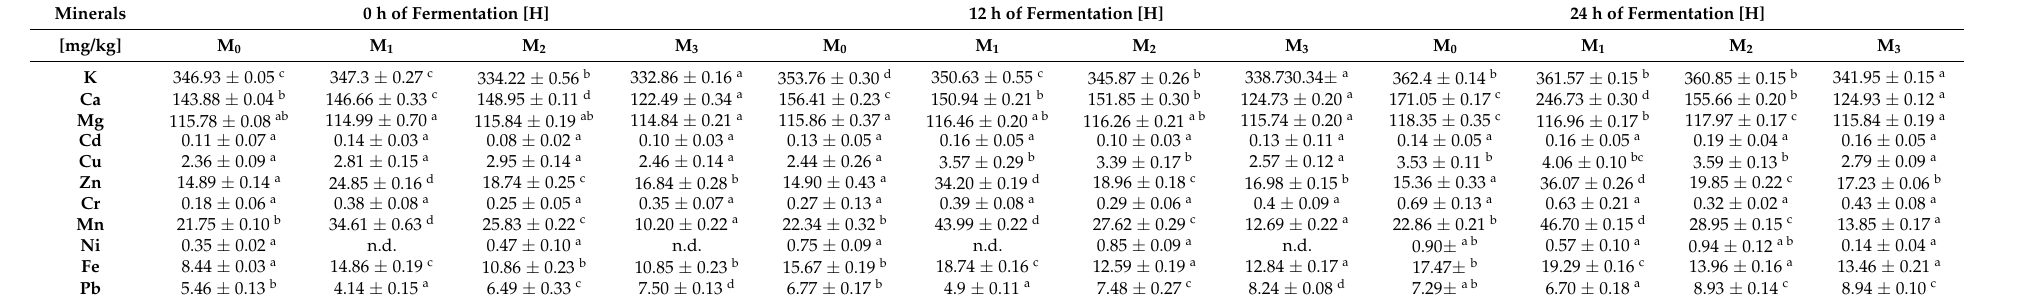
Table 4. Micro and macronutrients in sourdough with wheat flour (M 0 ), einkorn flour (M 1 ), spelt flour (M 2 ), and emmer flour (M 3 ), fermented for 0, 12, and 24 h with Lactiplantibacillus plantarum ATCC